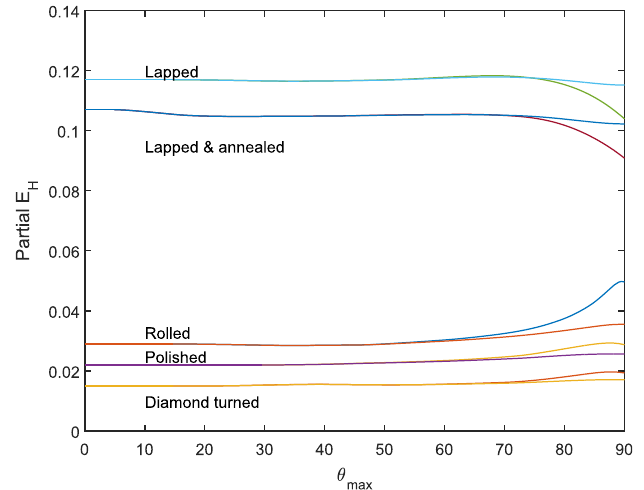
Fig. 4. Emittance of gold with a variety of surface fi nishes as labeled. The two partial hemispherical plots for each fi nish are E e ( D V ) and E p ( D V ). u max =90 ° yields E He and E Hp . E p ( D V ) has the much fl atter variation with size increase of each hemispherical cap in the high u max range.